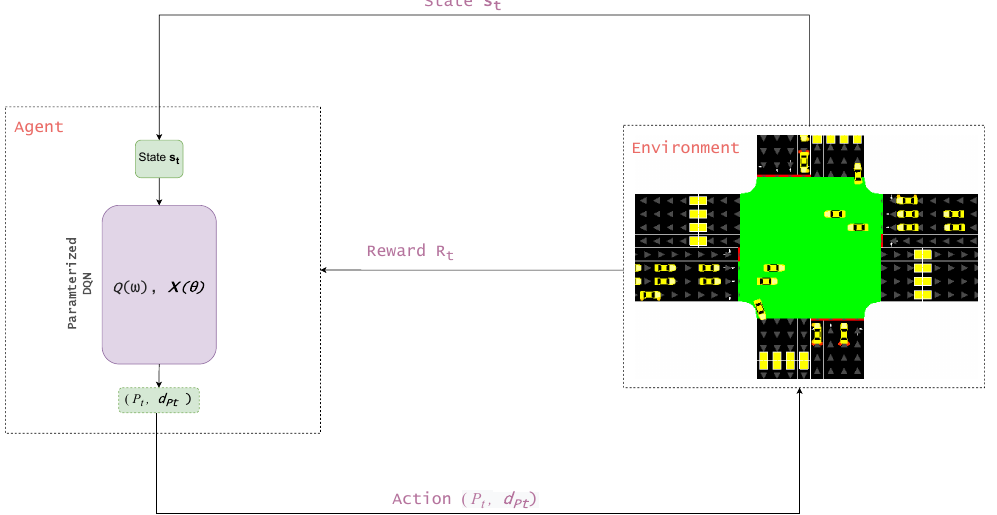
Figure 2. Overview of the framework structure for traffic signal control with Phase and Duration